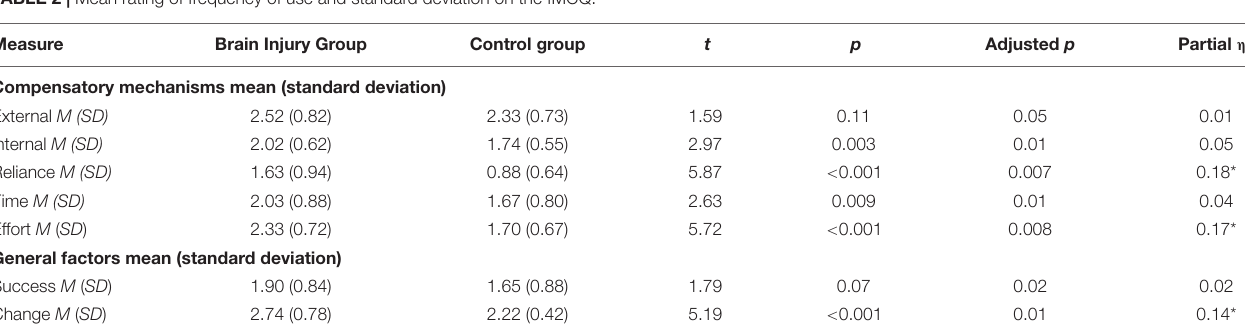
TABLE 2 | Mean rating of frequency of use and standard deviation on the